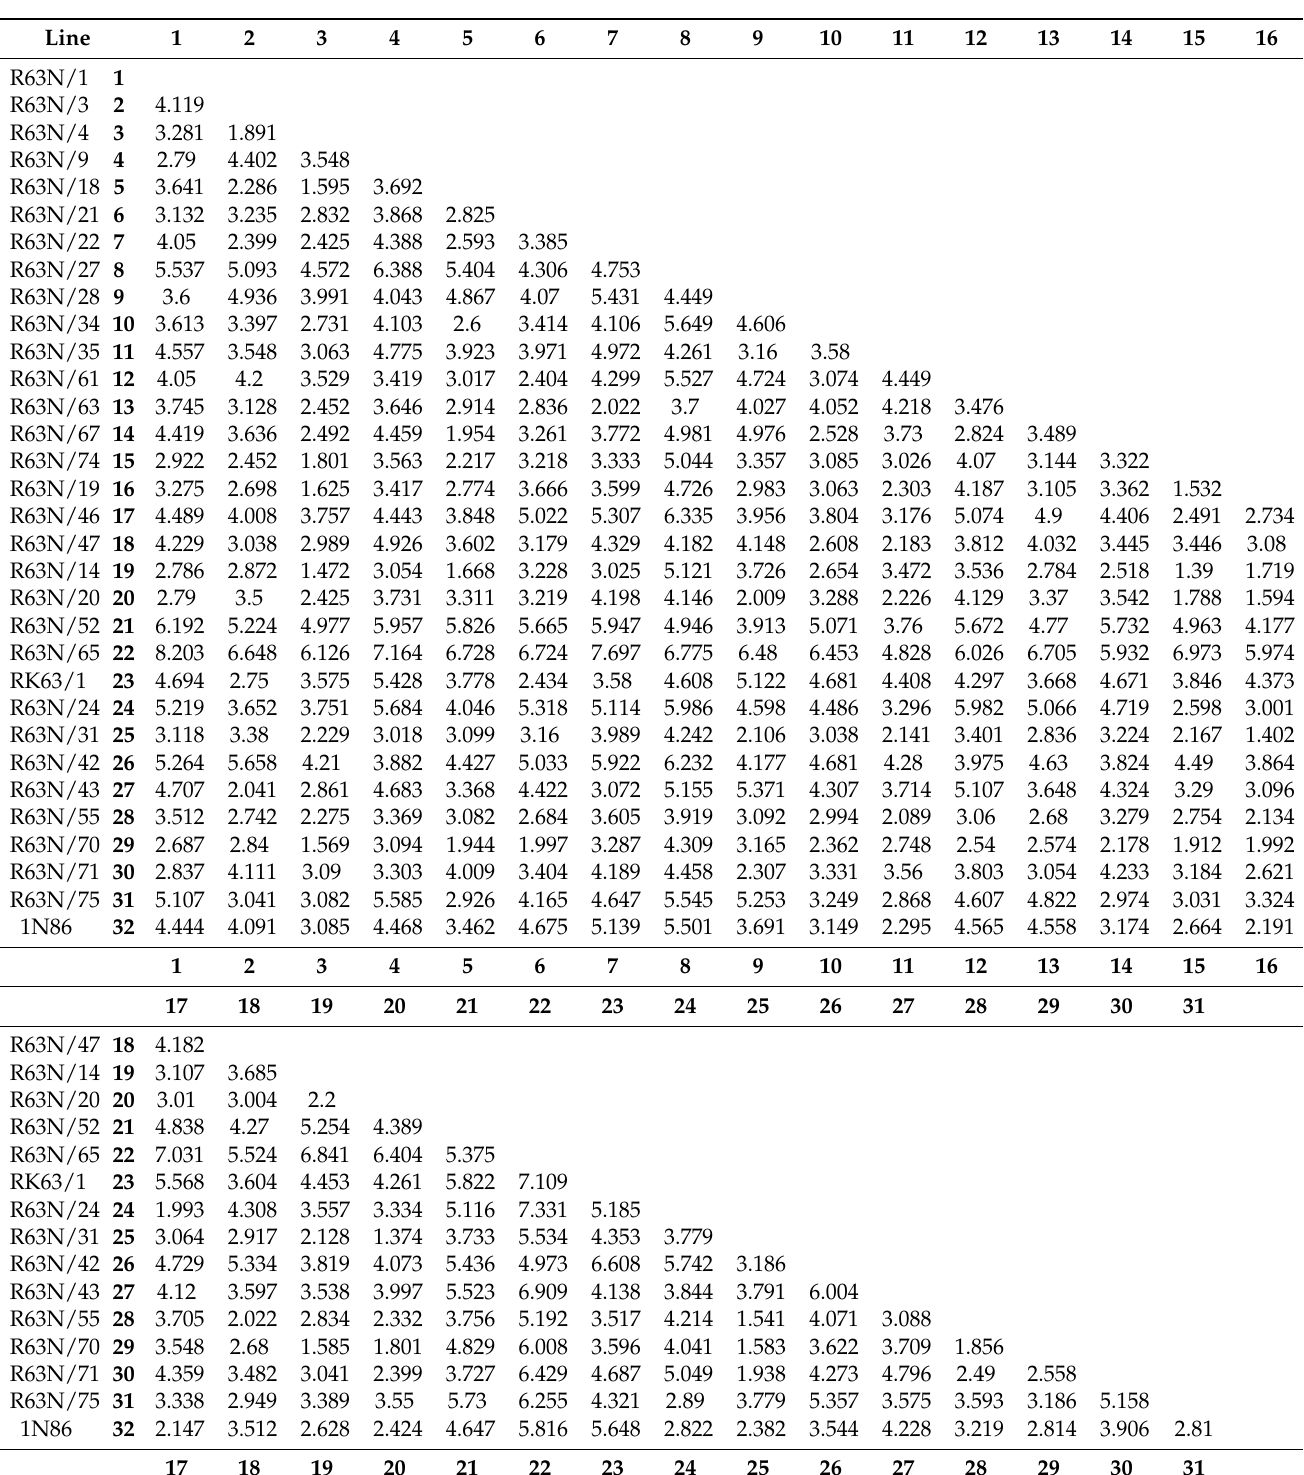
Table 5. Mahalanobis distances between analyzed 32 barley DH